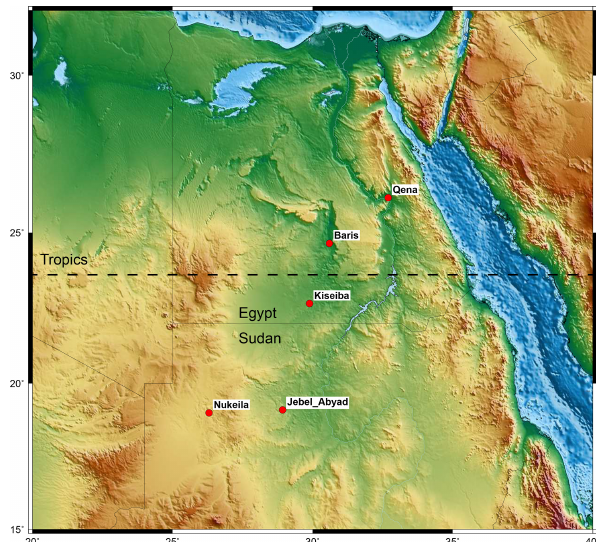
Figure 1. Locations of the fossil assemblages studied. The location map shows the studied areas. The topographic map was created us- ing the generic mapping tools of Wessel and Luis (2017) and the topographic data set ETOPO1 of Amante and Eakins